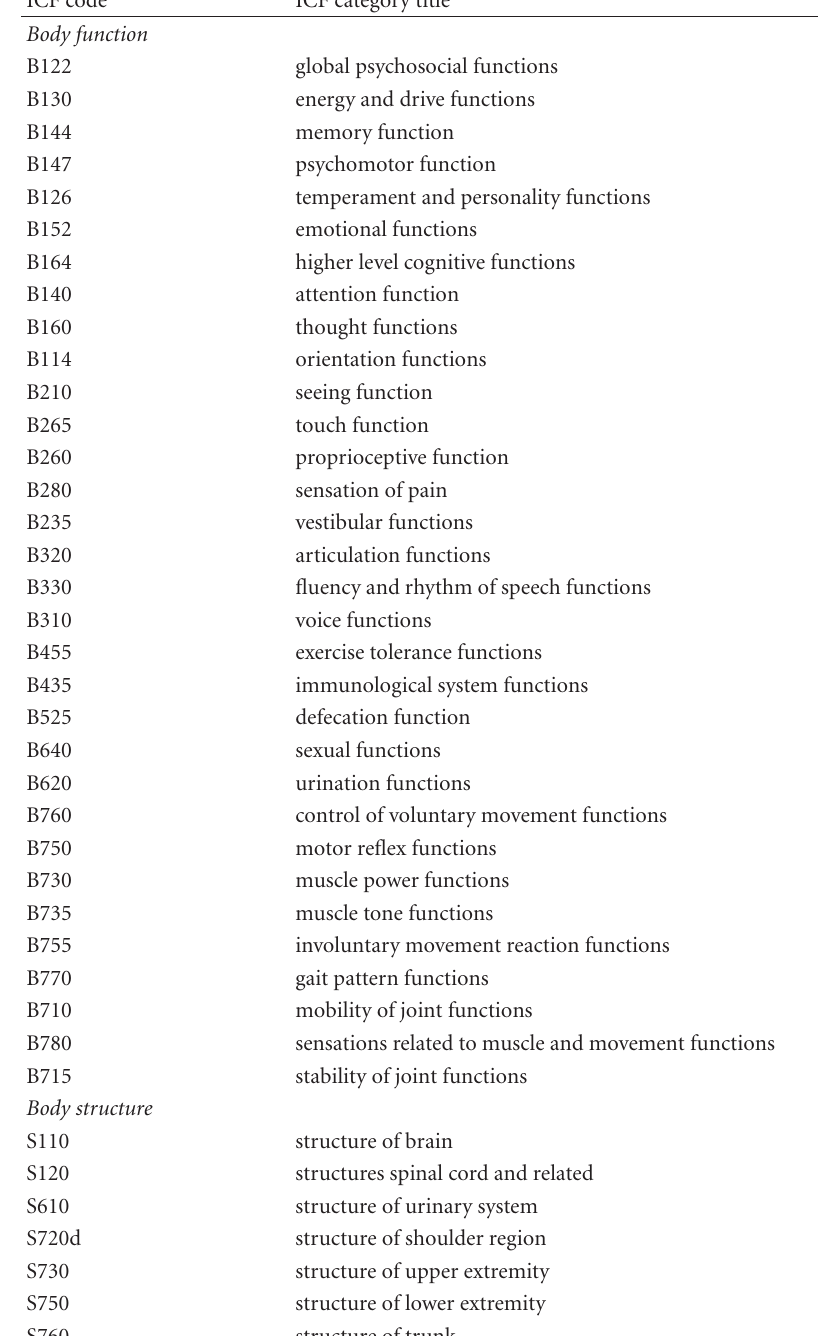
Table 2: International classification of functioning, disability, and health (ICF) categories for the components: body “function” and body “structure” included in the “core” set for persons with MS for comprehensive multidisciplinary